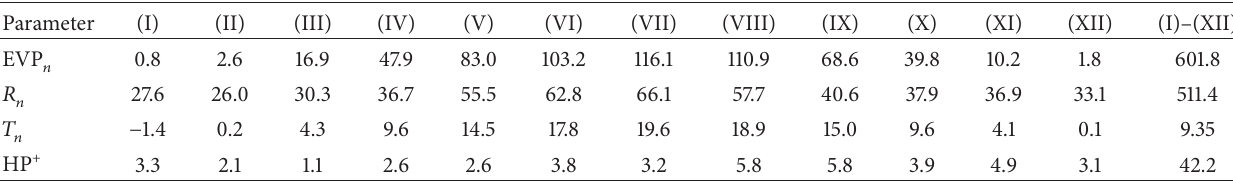
Table 2: Long-term monthly precipitation totals ( 𝑅 𝑛 ), average monthly air temperatures ( 𝑇 𝑛 ), and potential evapotranspiration (EVP 𝑛 ) in the area of floodplain forests for the period 1851–2011 (all values are given in mm).